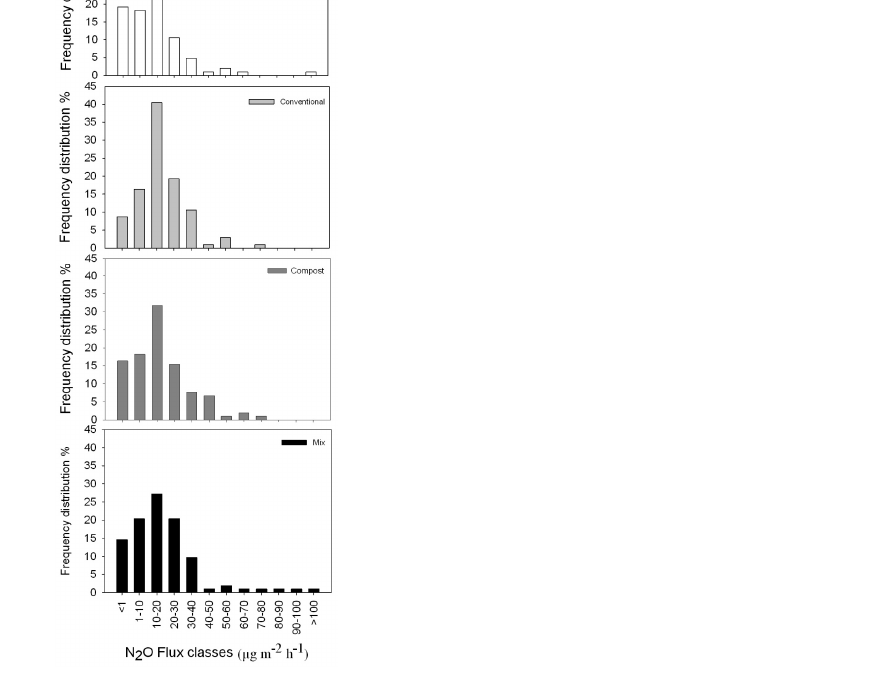
Figure 3. N 2 O hourly flux (A) and cumulative flux (B) measured in the plots of the four treatments between 13 May and 25 July 2013. DAF stands for days after fertilization event (13 May 2013). Error bars represent one standard deviation (n = 8). Dotted lines represent the fertilization event (1 st line) and the first crop harvesting (2 nd line).